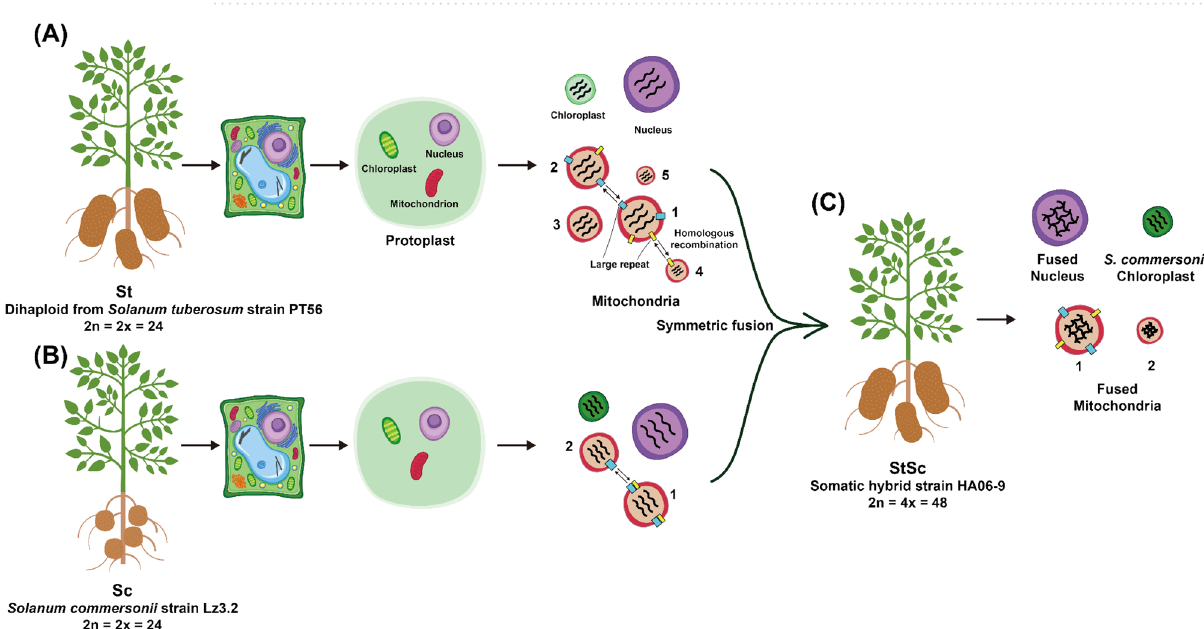
Figure 4. Schematic diagram of mitogenome in parental species and their somatic hybrids. ( A ) S. tuberosum (St), ( B ) S. commersonii (Sc) , and ( C ) somatic hybrid (StSc). S. tuberosum and S. commersonii have five and two subgenomes, respectively, which are fused into two subgenomes in the somatic hybrid generated by protoplast fusion. The origin of chloroplast genome in somatic hybrid has been determined based on sequence comparison among chloroplast genome sequences of parental species and that of the somatic